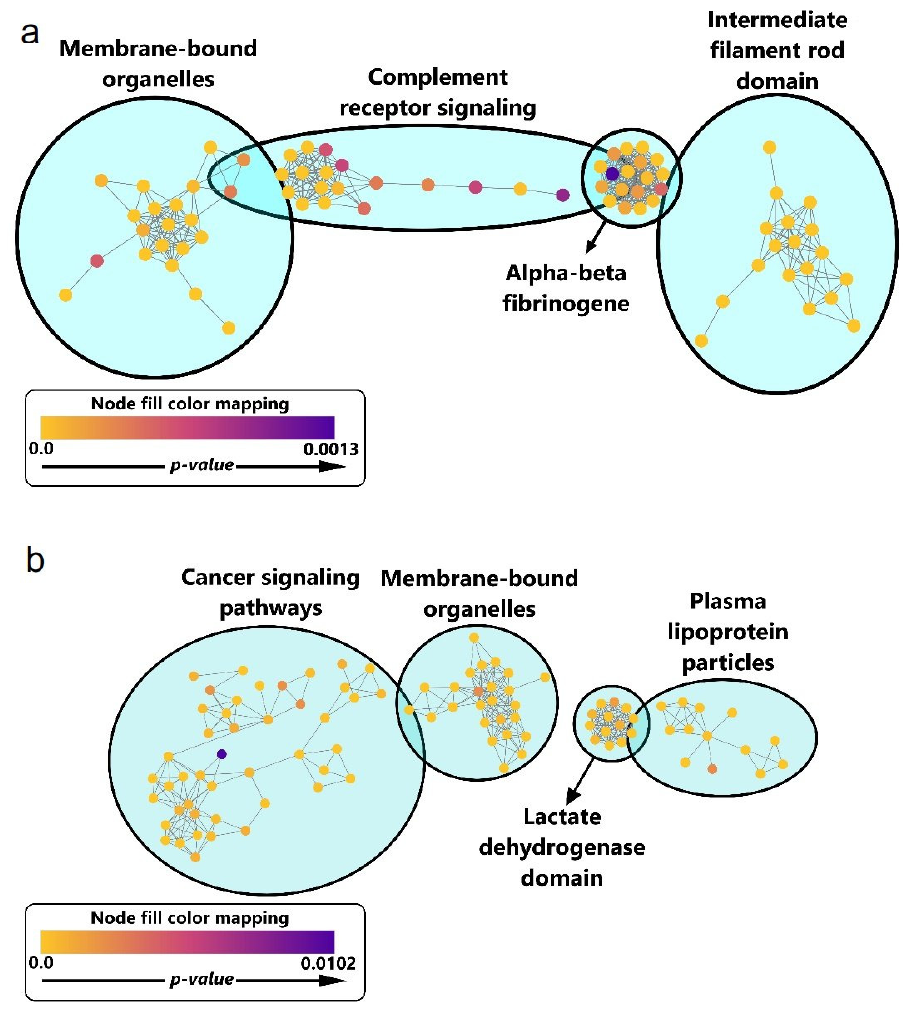
Figure A4. Constructed enrichment map for significantly regulated proteins (adjusted p -value < 0.05). ( a ) Enrichment map of the significantly regulated proteins identified by comparison of MPE samples versus EBPE samples. Membrane-bound organelle cluster with 21 pathways inside is the largest cluster. ( b ) Enrichment map of the significantly regulated proteins identified by comparison of MPE samples versus BPE samples. The cancer signaling pathways cloud correspond to the largest cluster with 45 pathways and metabolism-related pathways highlighted among them.